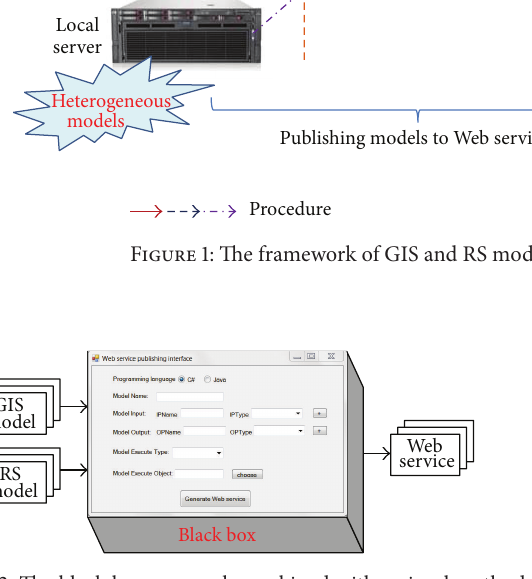
Figure 2: The black box approach combined with a visual method for publishing local models to Web